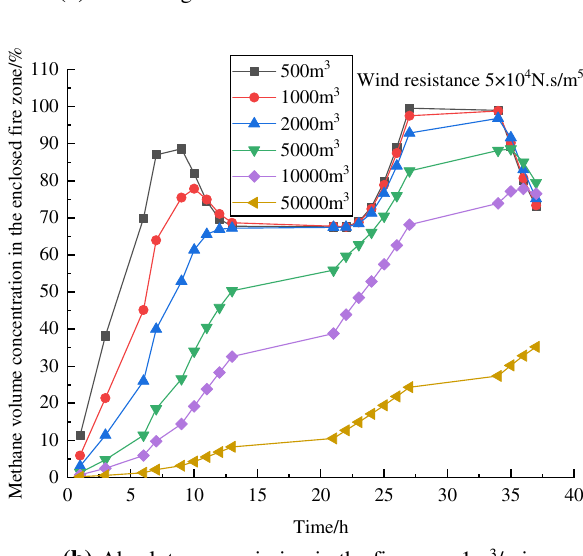
(a) Absolute gas emission in the fire zone 10m 3 /min